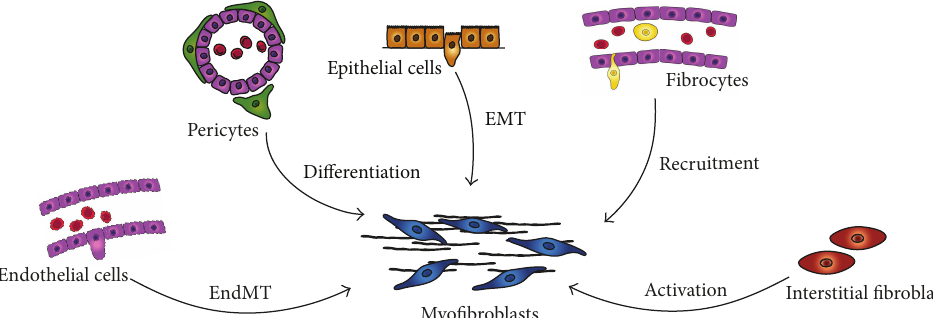
Figure 2: Multiple origins of myofibroblasts have been proposed in tissue fibrosis. Myofibroblasts may derive from at least five different sources through various mechanisms: phenotypic activation from interstitial fibroblasts; differentiation from vascular pericytes; recruitment from circulating fibrocytes; capillary endothelial-mesenchymal transition (EndMT); and epithelial-mesenchymal transition (EMT). The relative contribution of each source to the myofibroblast pool in peritoneal fibrosis still requires further